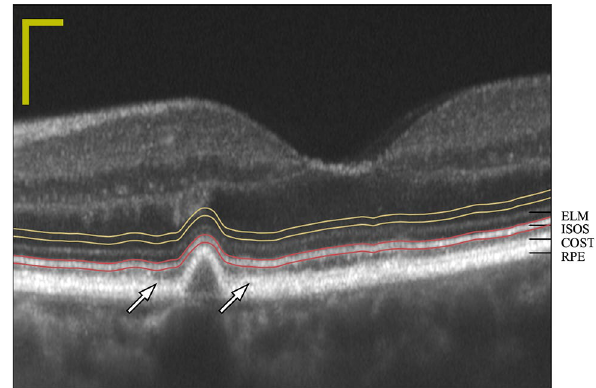
Figure 2. Example B-scan with segmented regions. An example of a B-scan from subject 2, shown in decibel (dB) scale. Dynamic ranges of images varied with pupil position and subject, with most B-scans falling between 30 and 45 dB. An isolated intermediate druse ( 100 µ m ) is visible, approximately 1.5 ◦ nasal to the fovea. The IS/ OS band was identified using a semi-automated procedure. The resulting trace through the band is indicated with two red lines, and the nominal depth of the inner-outer segment junction (IS/OS) is the point between those lines. The amount of light (amplitude) scattered by the IS/OS band is the vertical sum of the pixels lying between the red lines. IS/OS amplitude was normalized by dividing its value by that of a presumably isotropic scattering region in the outer nuclear layer (ONL), indicated here with two yellow lines. In healthy parts of most retinae, at least four outer retinal bands are visible, likely originating from the external limiting membrane (ELM), IS/OS, cone outer segment tips (COST), and retinal pigmented epithelium (RPE), labeled at the right edge of the image. Above the druse, only three bands are visible—ELM, IS/OS, and a third, broader band, which separates into COST and RPE (white arrows) at the interface with the non-drusen zone. Scale bars indicate 100 µ m in each